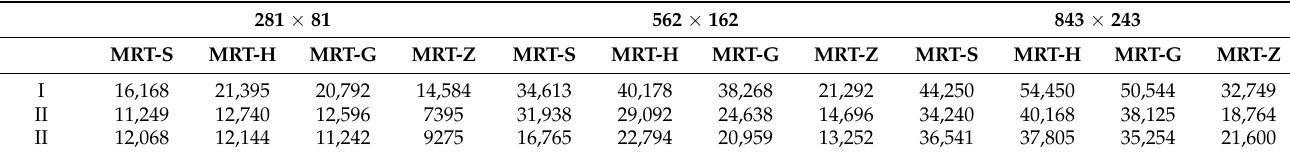
Table 3. Number of iterations necessary for convergence